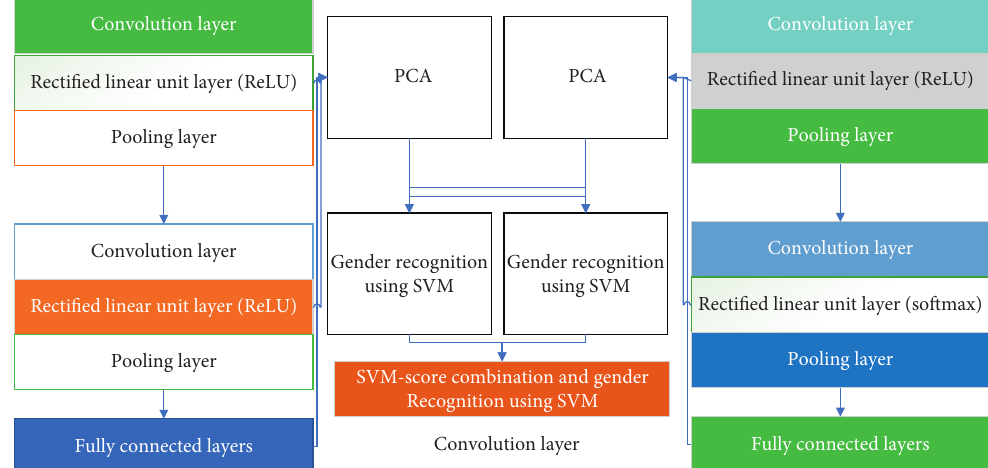
Figure 4: Mural off area calibration module diagram.